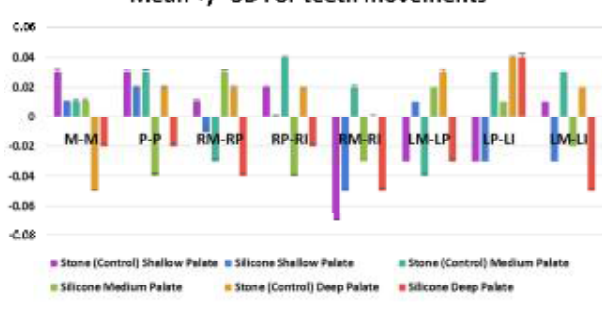
Fig. 6: Bar Chart Shows the mean and standard deviations for both Palatal Adaptation when acrylic resin processed by water bath.